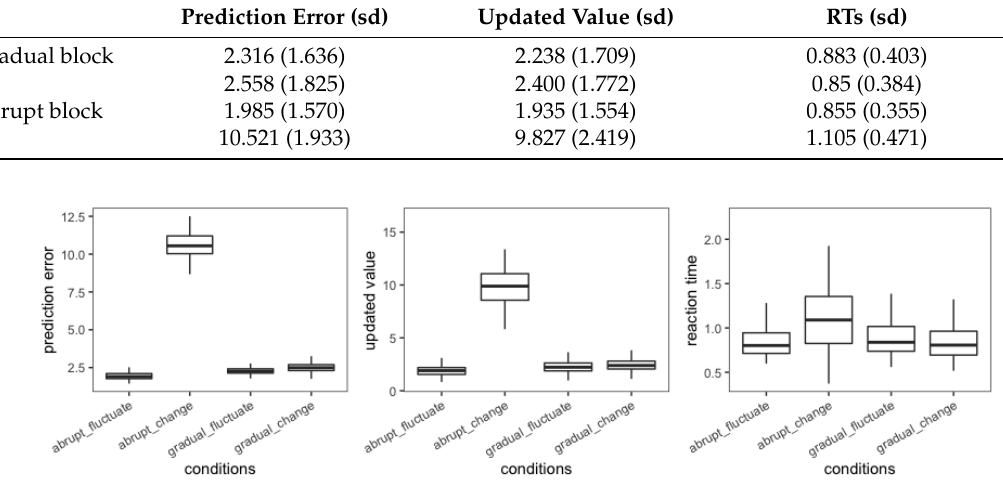
Figure 3. Box plot of distributions of means under different conditions.